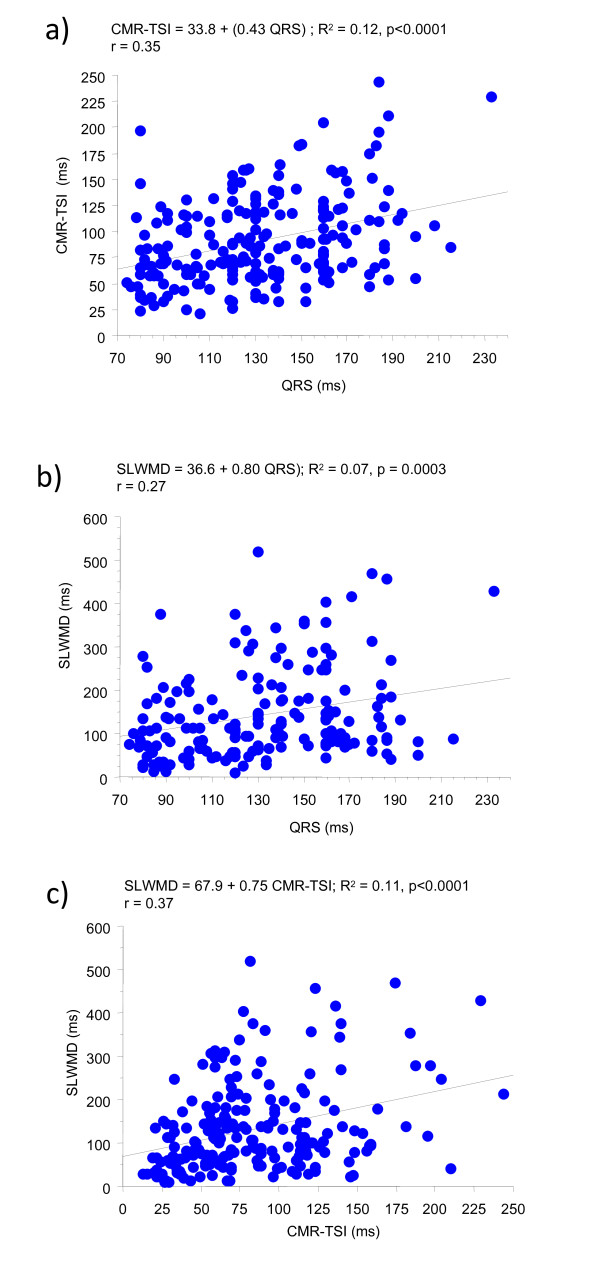
Regression and correlation analyses of CMR-TSI, QRS duration and SLWMD. Regression and correlation analyses of QRS duration against a) cardiovascular magnetic resonance tissue synchronization index (CMR-TSI) and b) septal-to-lateral wall motion delay (SLWMD); c) regression and correlation analysis of SLWMD against CMR-TSI. Data relates to 225 patients with heart failure.